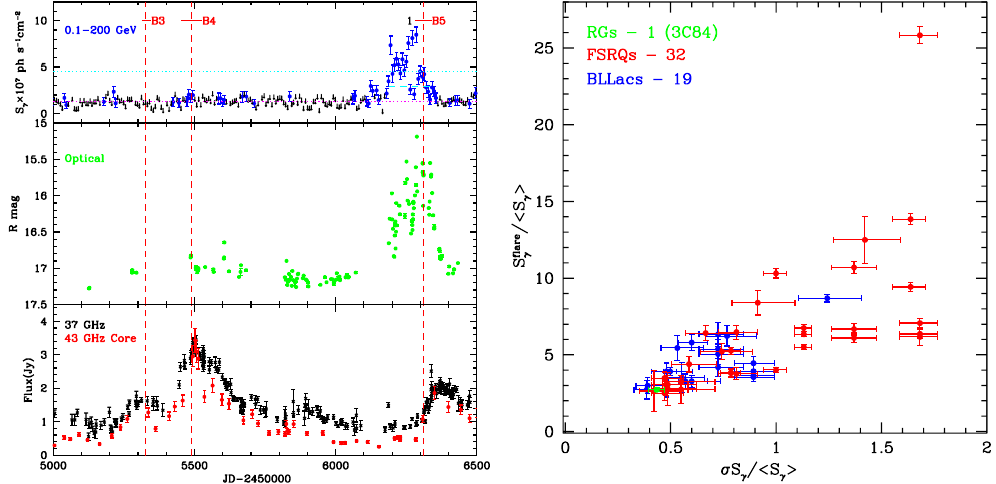
Figure 4. Left: The γ -ray (top), optical (middle), and mm wave light curves of the quasar 0827+243. The verical red dashed lines show times of ejection of superluminal knots. The dotted magenta and cyan lines indicate the weighted mean γ -ray flux, (cid:104) S γ (cid:105) , and the level of (cid:104) S γ (cid:105) + 3 σ , respectively, while the cyan dashed line marks the duration of the flare; Right: The maximum γ -ray flux during 3 σ γ events with respect to (cid:104) S γ (cid:105) vs. standard deviation of γ -ray flux normalized by (cid:104) S γ (cid:105) for each source; (cid:104) S γ (cid:105) and σ γ are calculated using γ -ray light curves with a 7-day binning